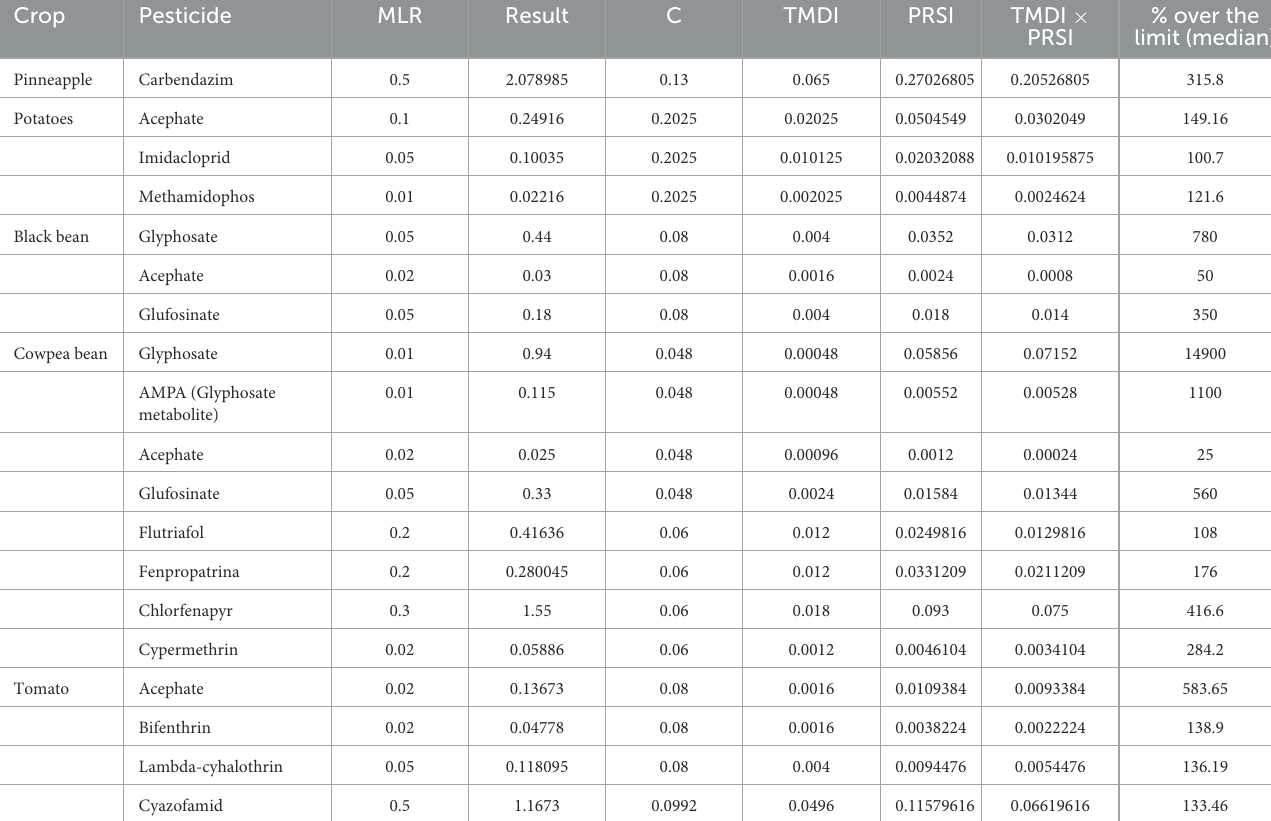
TABLE 3 Pesticide active substances percentages applied over the limit in agricultural crops according with TMDI and PRSI values in 2020. Crop